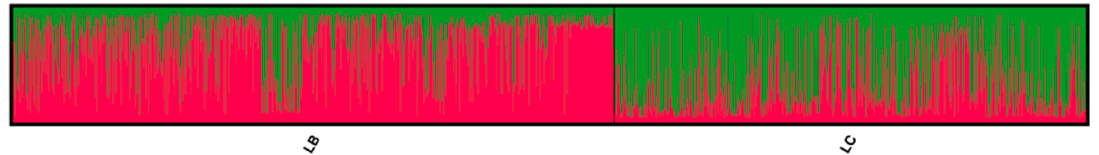
Figure 4. Results of Bayesian clustering of 2171 individuals from 2 genetic lines. The Structure plot represents the run when K = 2. Individuals are ordered by genetic line, and each of them is repre- sented by a line proportionally divided into color segments. The black line separates individuals from different genetic lines.